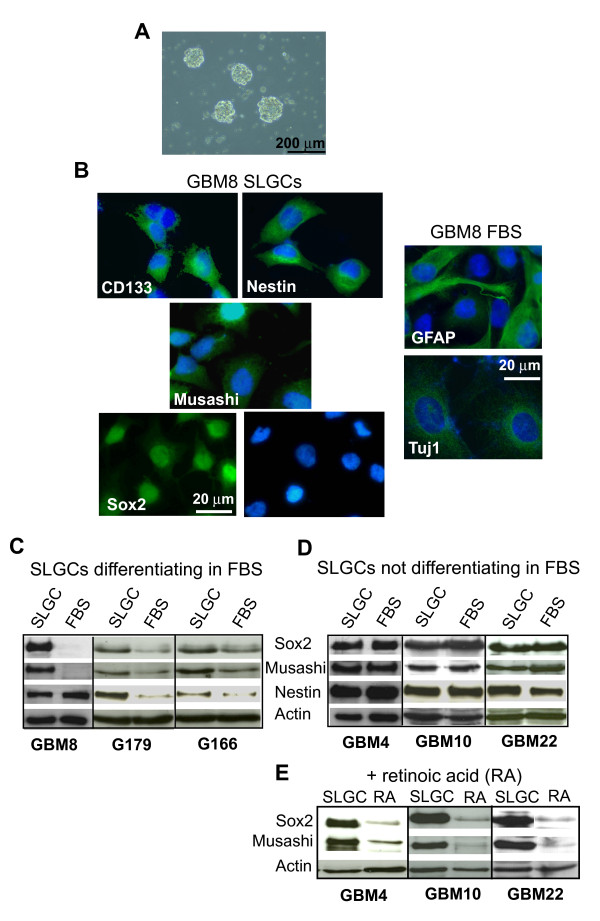
Characterization of SLGCs and FBS cultures derived directly from the SLGCs. A. Sphere formation 14 days after seeding 500 cells/well in 24 well plates. B. Immunofluorescence analysis of neural stem- and progenitor markers (Sox2, CD133, musashi, nestin) and differentiation markers (GFAP, Tuj) in SLGC and in differentiating FBS cultures. Nuclei were counterstained with DAPI. C-E. Western blot analysis of stem- and progenitor markers of SLGCs differentiating in FBS-containing medium (C), of SLGCs resistant to differention in FBS-containing medium (D) but differentiating after exposure to vitamin A (E). Blots shown are representative of at least three independent experiments. The analyses were performed after culturing for 4 weeks under differentiating conditions.